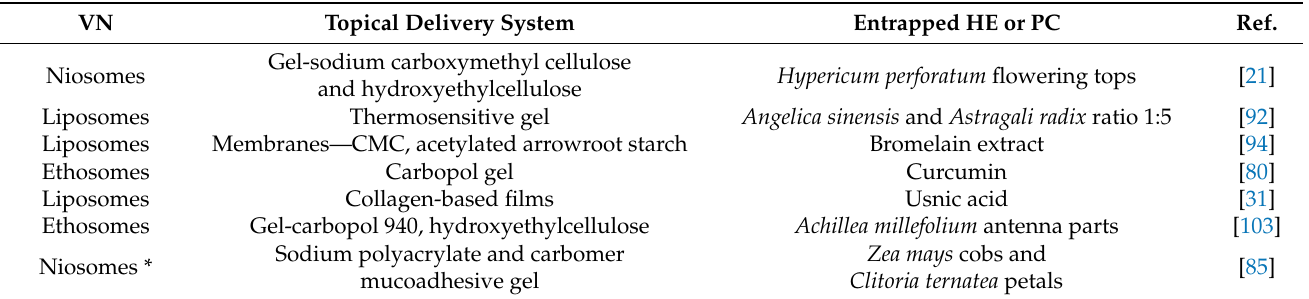
Table 6. Vesicular nanosystems bearing herbal extracts or phytocompounds incorporated in topical systems for wound